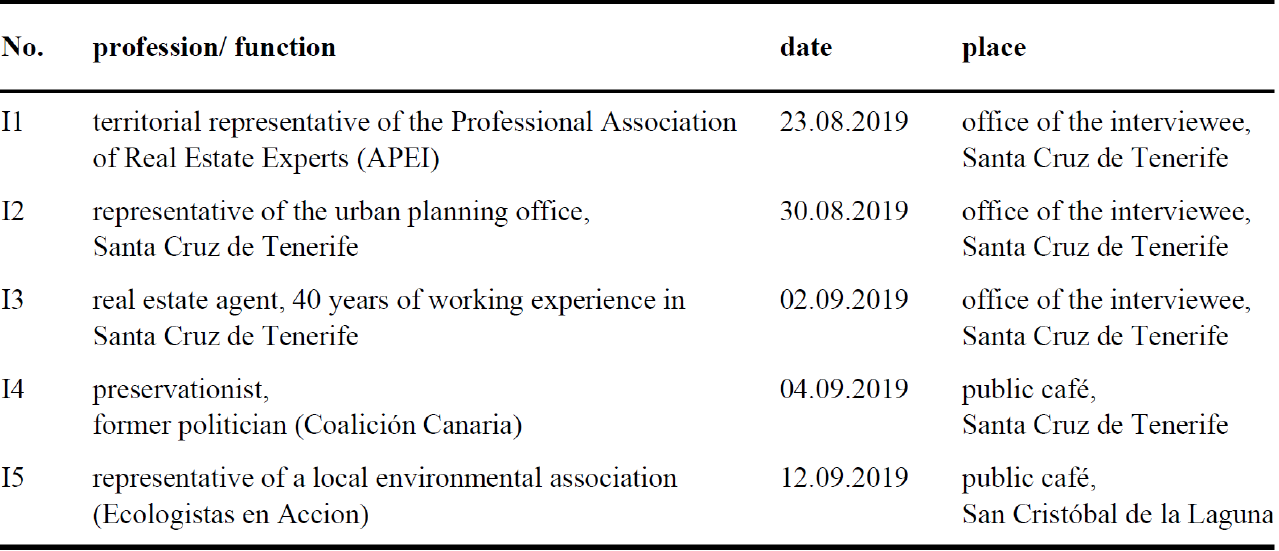
Figure 4. Interviewees and their professions. Own elaboration.